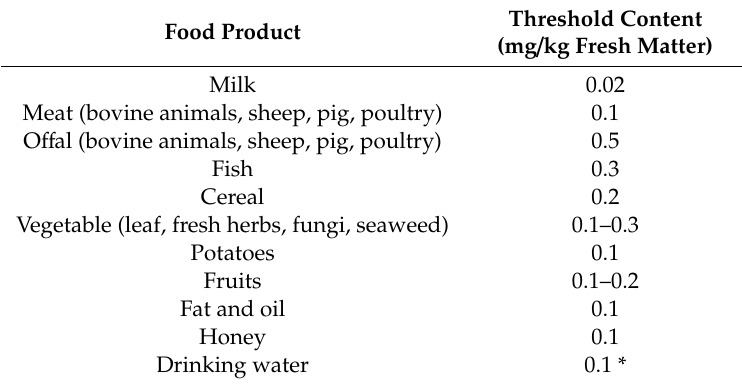
Table 3. Threshold lead contents in selected food products [9,12,39,40].